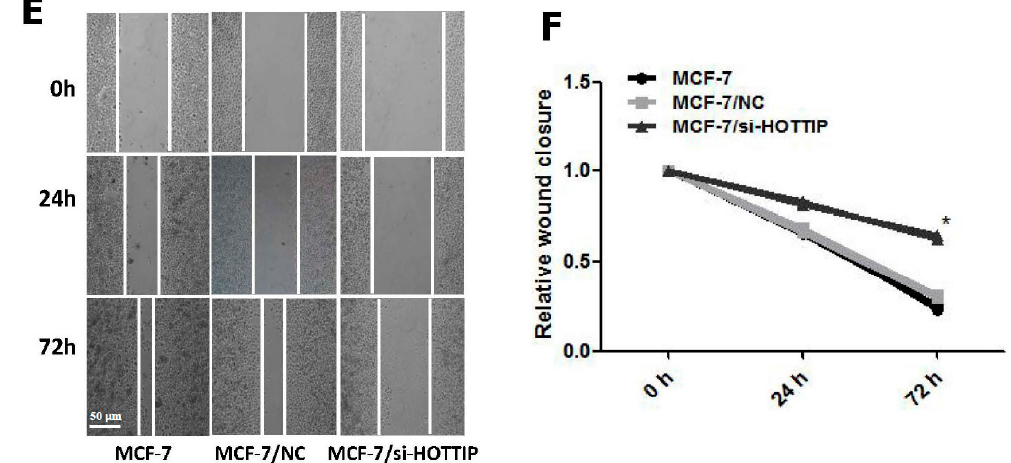
Figure 2. HOTTIP may promote cell growth in vivo, suppress cell apoptosis and promote cell migration in vitro in breast cancer cells. ( A ): Image showing excised tumors from tumor-bearing nude mouse for each treatment. ( B ): Volume change curve of each group measured on the indicated days. ( C ): Tumor weights of each group were determined. ( D ): HOTTIP knockdown may induce apoptosis of MCF-7 cells. ( E ): HOTTIP knockdown may inhibit cell migration ability of MCF-7. ( F ): Quantitative results of wound closure rate with HOTTIP knockdown in MCF-7 cells. * p < 0.05. Scale bar represents 50 μ m.